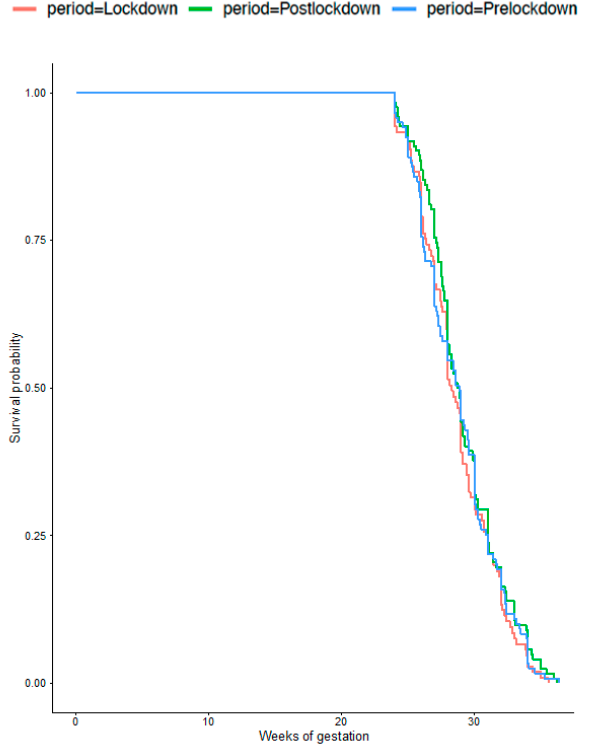
Figure 1. Gestational age at delivery for women with very low birthweight infants (<1500 g) ( p = 0.7).